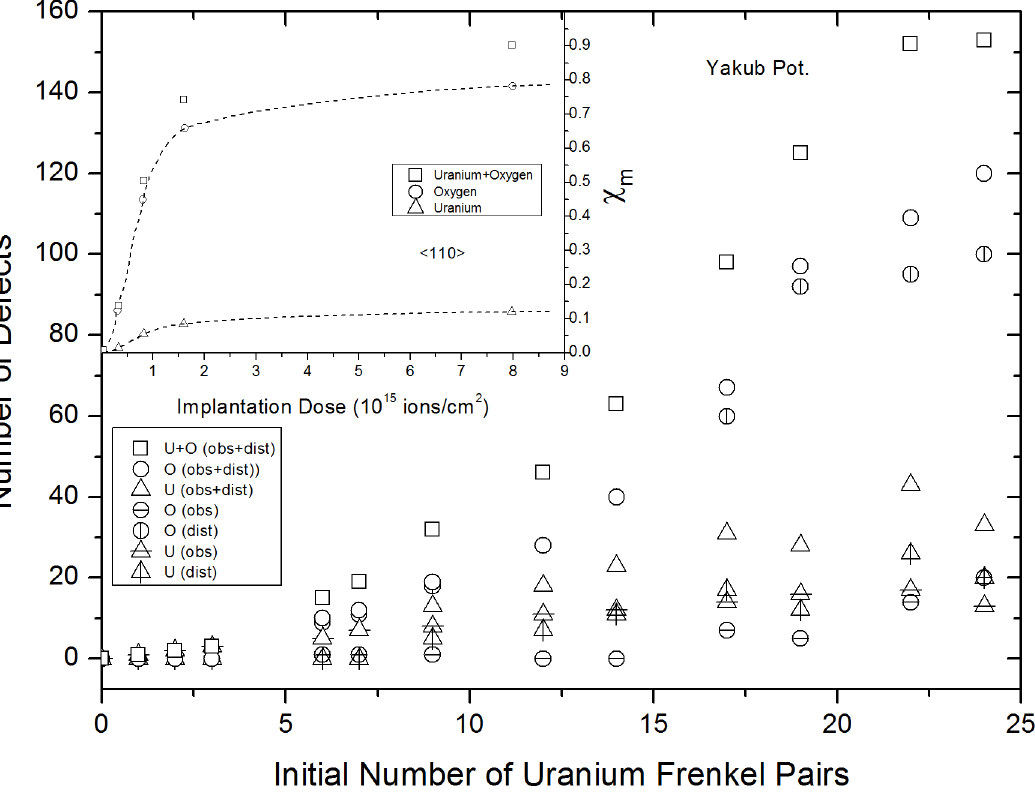
Fig 6. Yakub potential results for variations in numbers of remaining and created FPs versus uranium IFPs. The inset was taken from Ref. 28 and shows the experimentally determined concentrations of uranium and oxygen FPs created, as functions of dose.